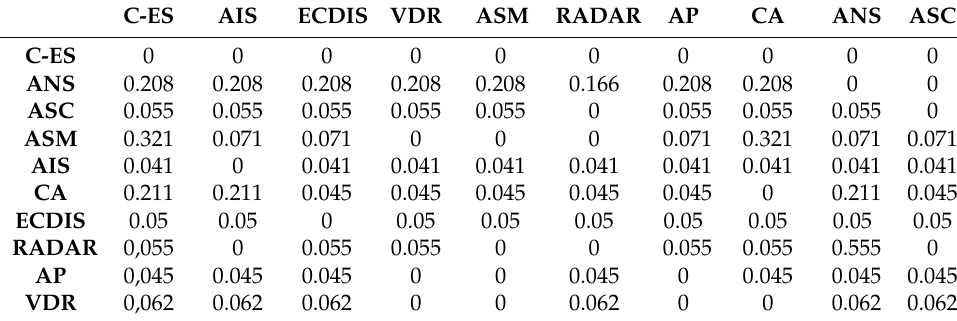
Table 4. Effect coefficients—Autonomous